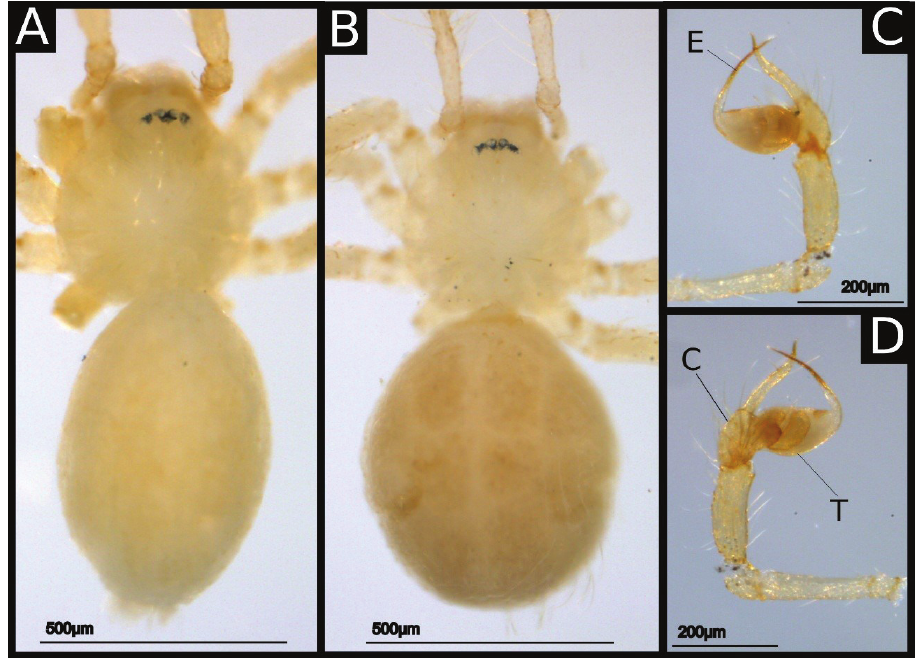
Figure 11. Ochyrocera rosinha sp. nov., male (IBSP 196435) A habitus, dorsal view B female (UFLA 60680), habitus, dorsal view C left male palp, prolateral view D same, retrolateral view. Abbreviations: C, cymbium; E, embolus; T,